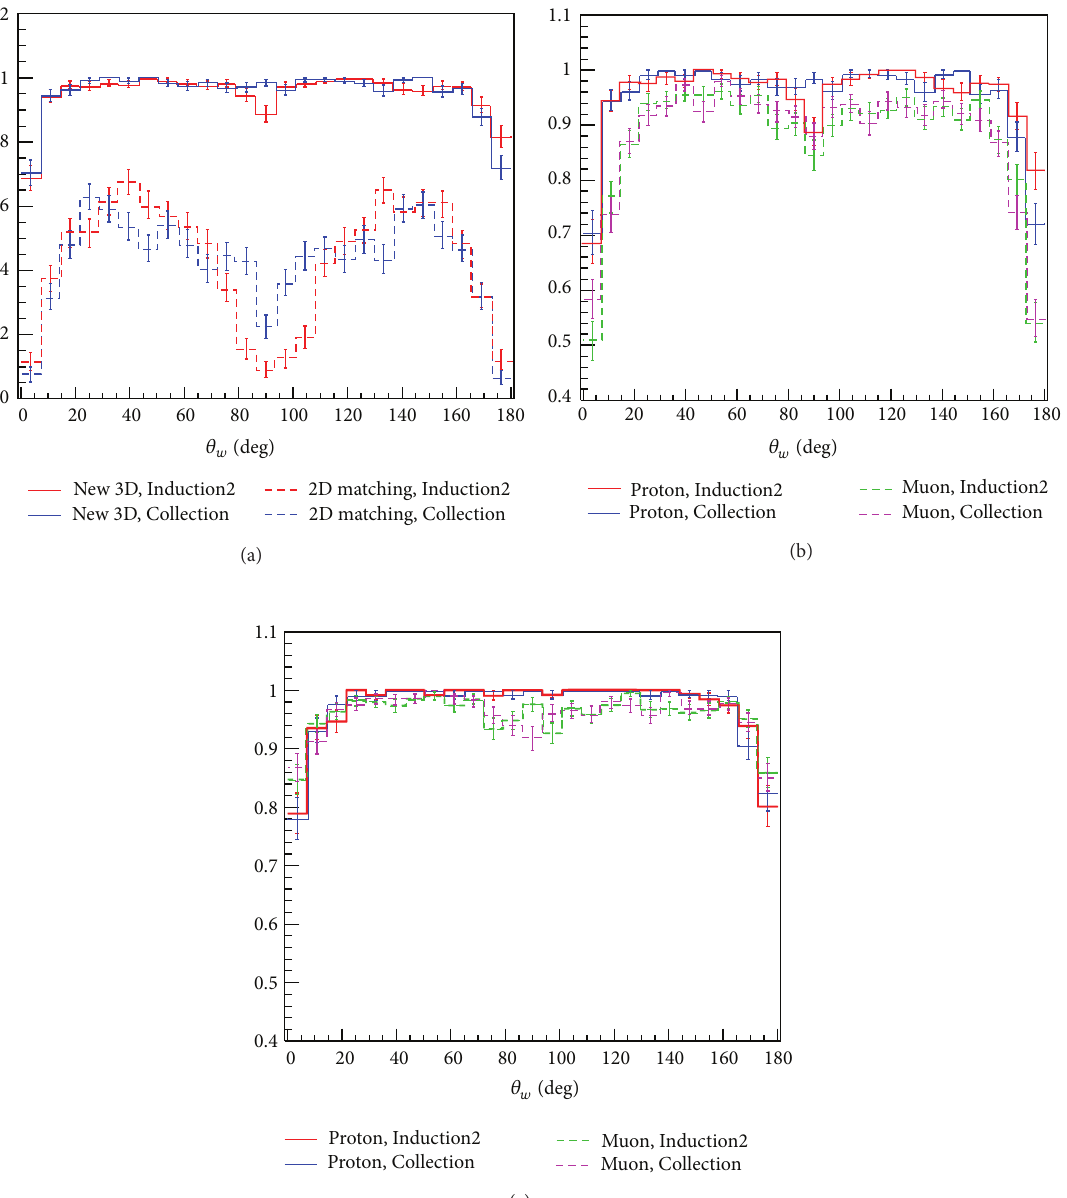
Figure 10: Fraction of the reconstructed proton and muon tracks with the maximum MC cell distance to the reconstructed track below 5mm as a function of the initial track direction with respect to the normal to wires of Collection and Induction2 planes: (a) comparison of the new 3D method with the approach based on 2D hit matching, proton tracks reconstructed using Collection and Induction2 planes only; (b) muon and proton tracks reconstructed with the new 3D method using Collection and Induction2 planes; (c) muon and proton tracks reconstructed with the new 3D method using Collection, Induction2, and Induction1